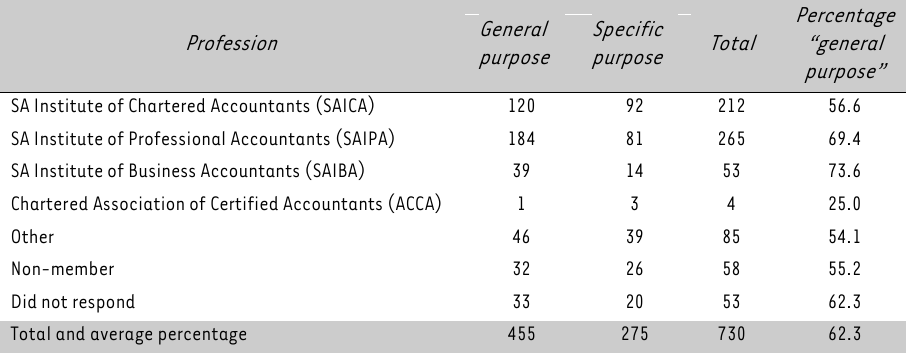
TABLE 5.1: Purpose of financial statements of micro and small entities, analysed by